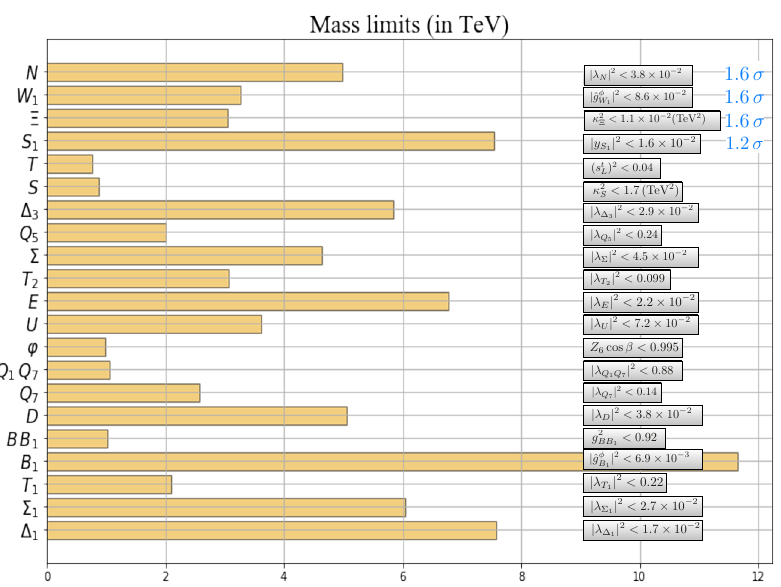
Figure 14 . The horizontal bars show the mass limits (in TeV) at the 95% CL for the models described in table 3, setting the corresponding couplings to unity. The coupling limits obtained when setting the mass to 1 TeV are shown in grey boxes. We also note in light blue the pulls that exceed 1- σ